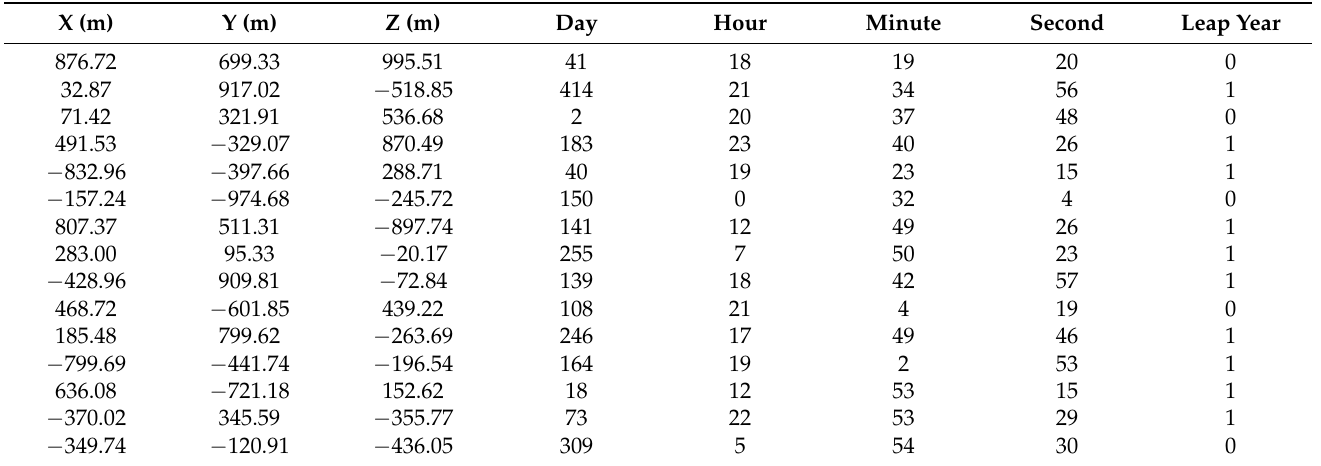
Table 4. Schematic table of spacetime simulation data.